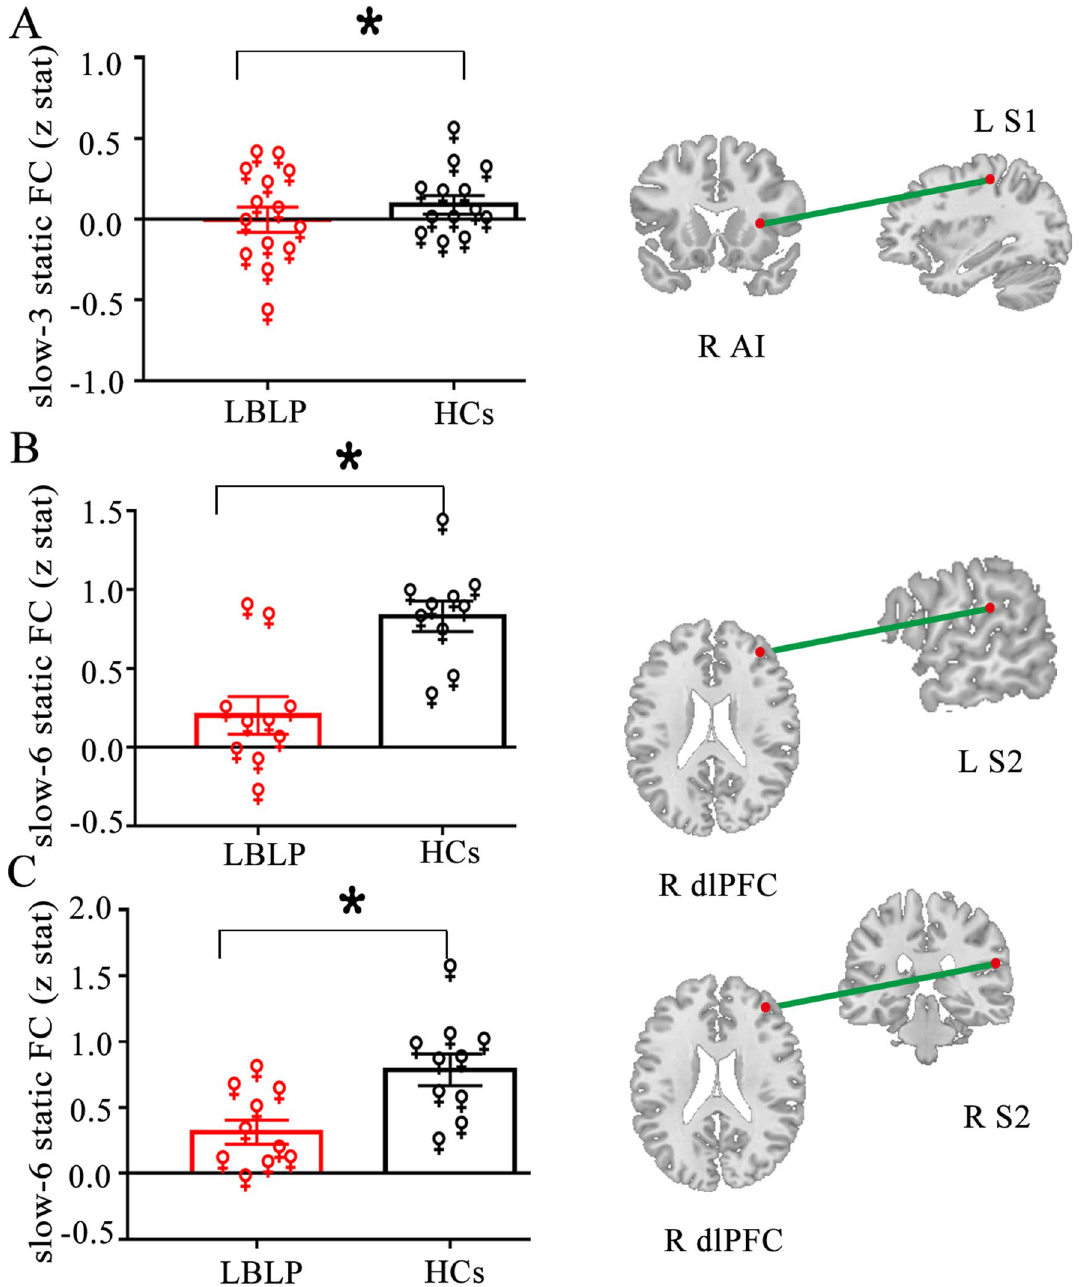
Figure 5. Female-specific analysis of differences between the LBLP and HCs groups. Two-sample t test, P < 0.05 with FDR